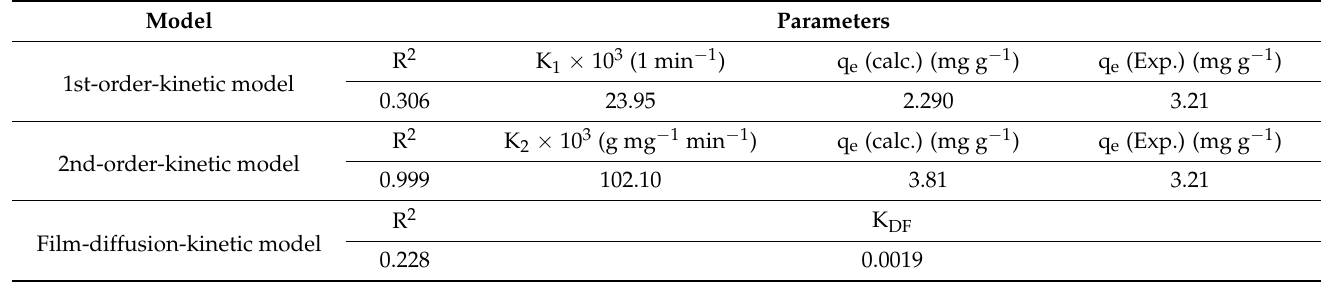
Table 5. Adsorption kinetics parameters.